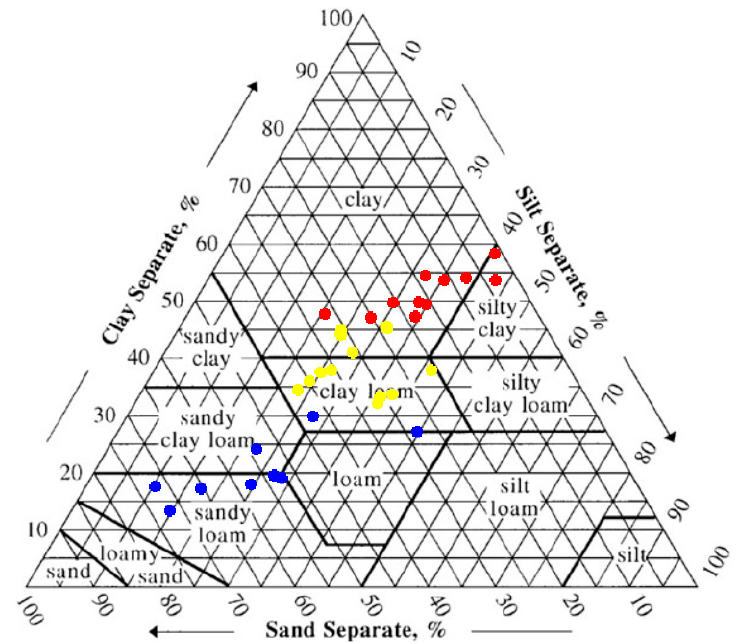
Figure 1. Soil texture samples over the Kairouan Plain, plotted on the soil texture triangle. A single point, corresponding to the average value of several soil samples, is used to represent each of the 33 reference fields.